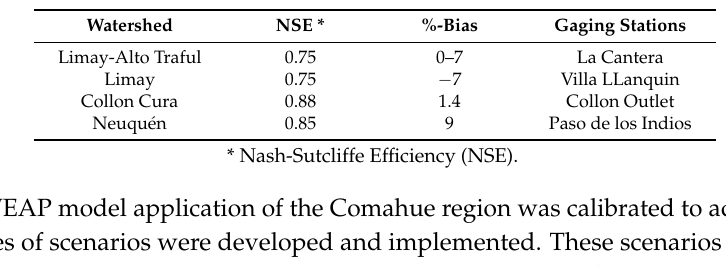
Table 3. Calibration performance for monthly flow discharges at the outlets of the watersheds for the period 2000–2010 (supply component).